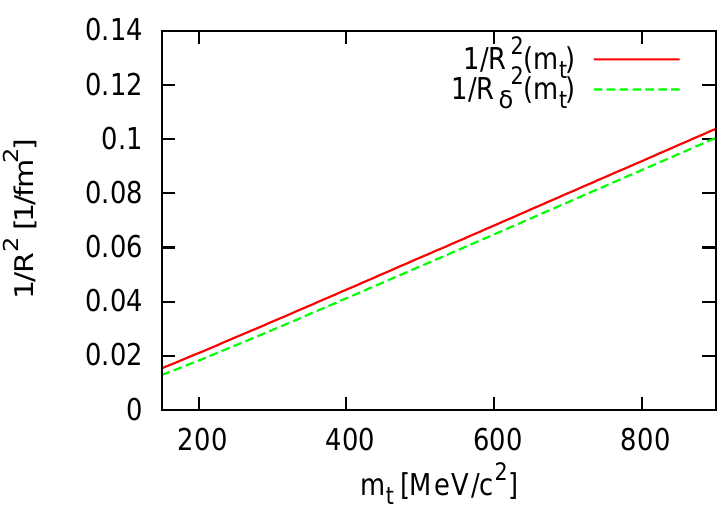
Figure 3. We can see the transverse mass scaling of the calculated HBT-radii, which is usually observed in experimental